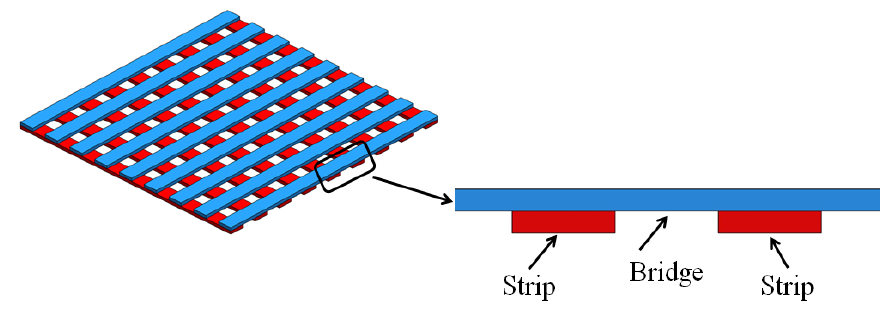
Figure 4. CAD model of a mesh showing strips and the bridges.